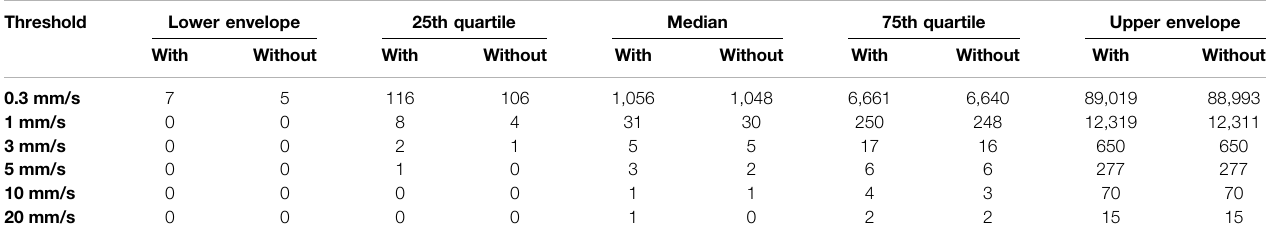
TABLE 5 | The number of exceedances determined for the full operational period with and without earthquake events at different velocity thresholds. Threshold Lower envelope 25th quartile Median 75th quartile Upper